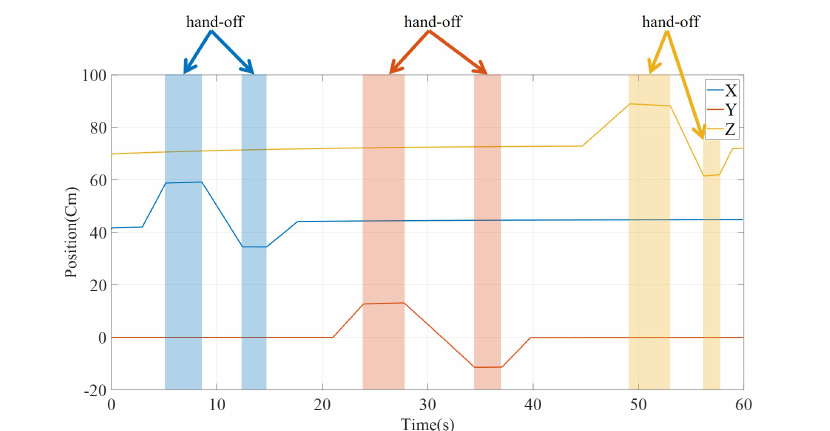
Figure 11. The end-effector position of K-handler to verify the gravity compensation